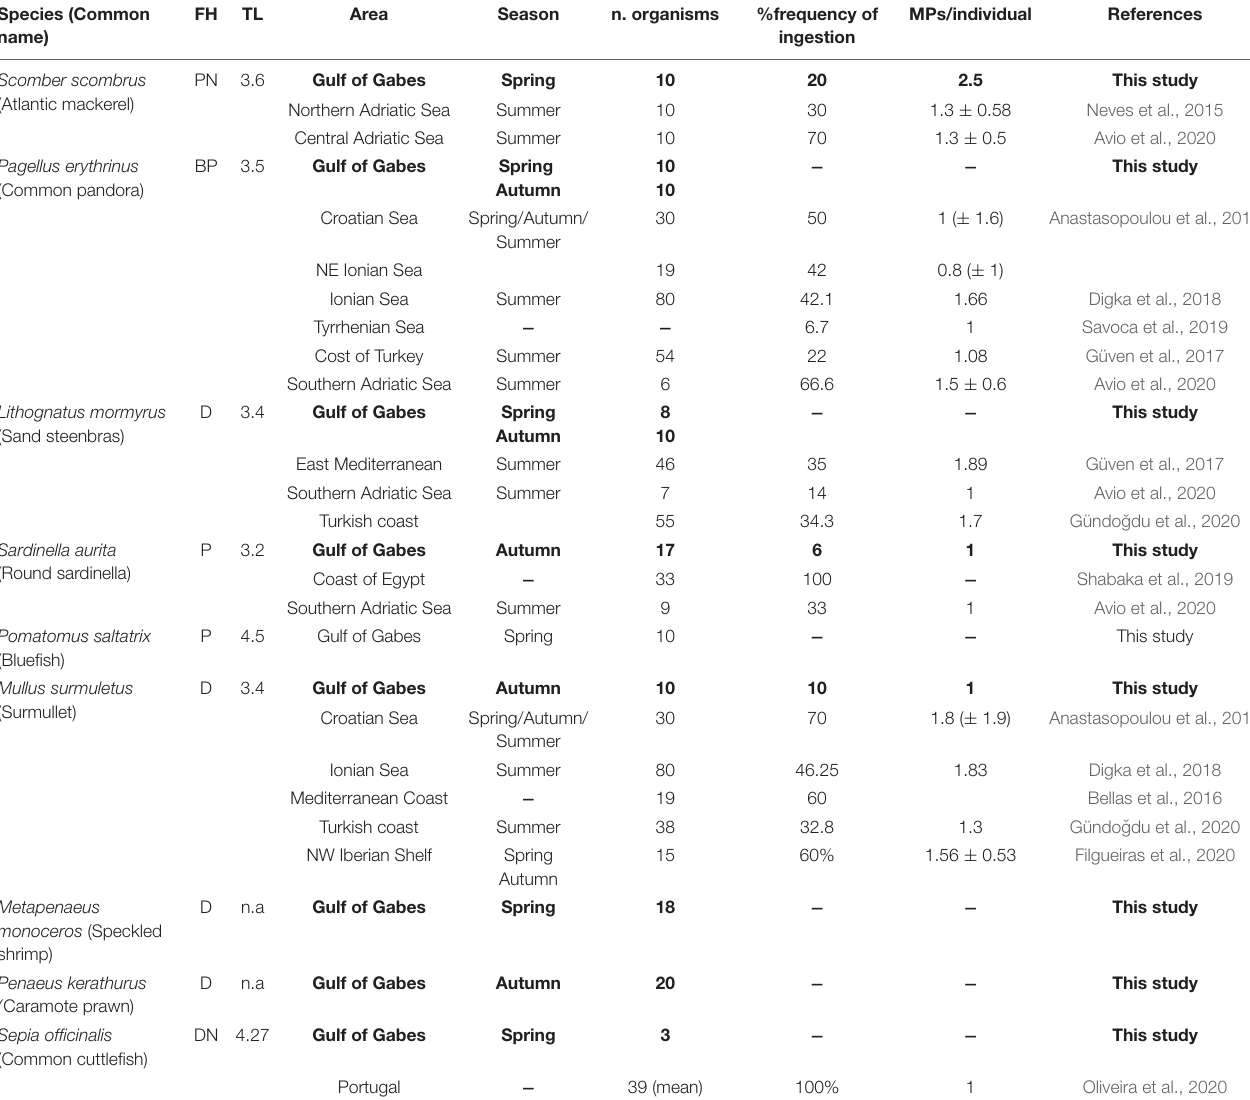
TABLE 2 | Species (common name), Feeding Habitat (FH), Trophic Level (TL), Sampling area and season, number of analyzed organisms, frequency (%) of ingestion, MPs ingested per individual obtained in the present study (in bold) and from